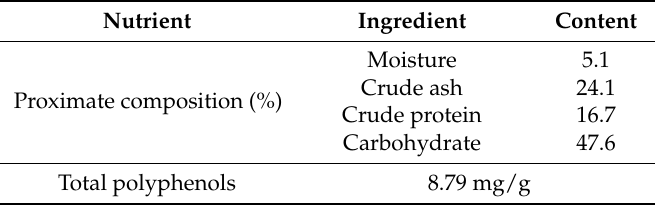
Table 10. Composition of GEE